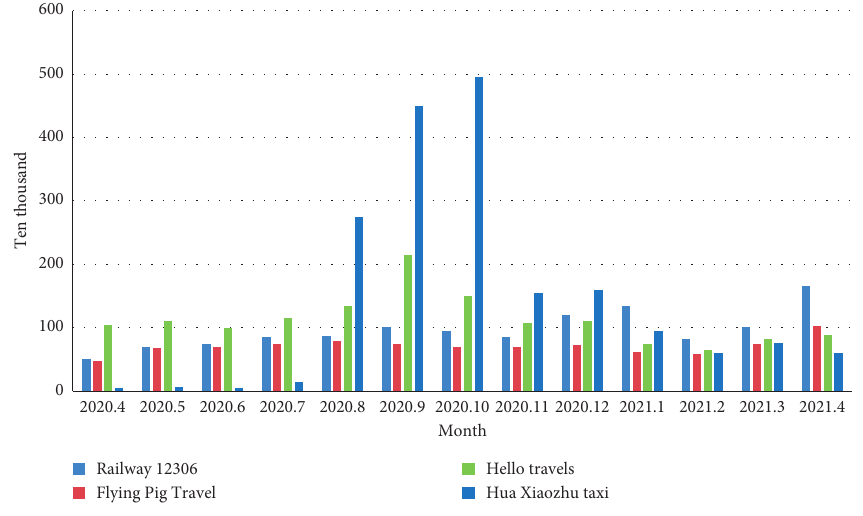
Figure 5: Travel visits of tourism platform.